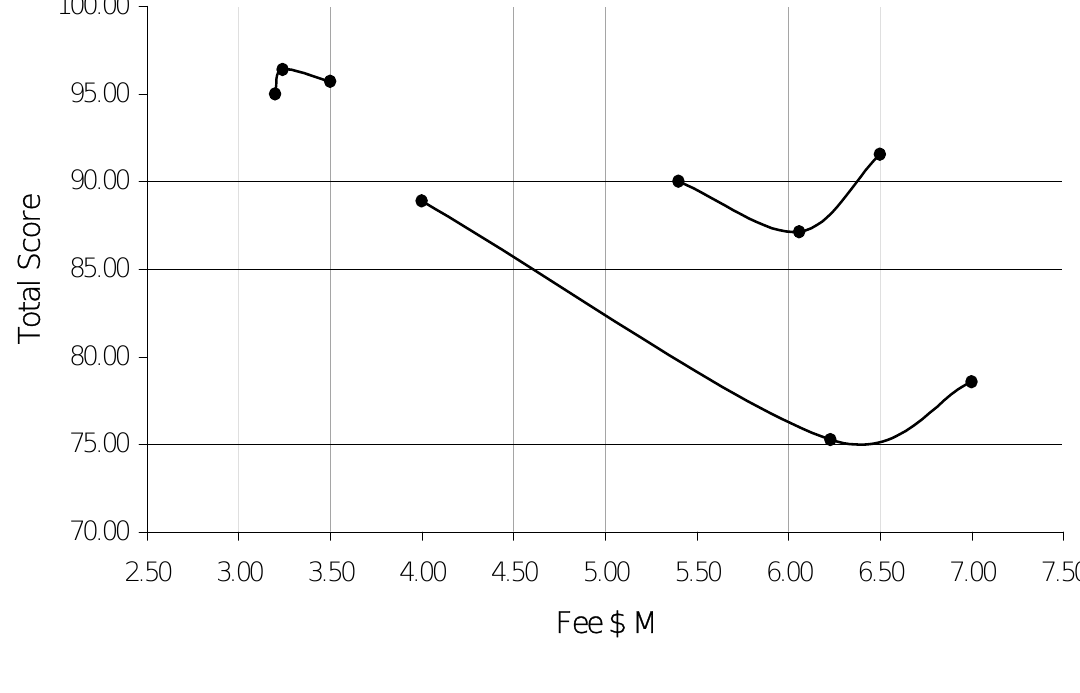
Figure 3: Total score continuums for Cases 36, 37 and